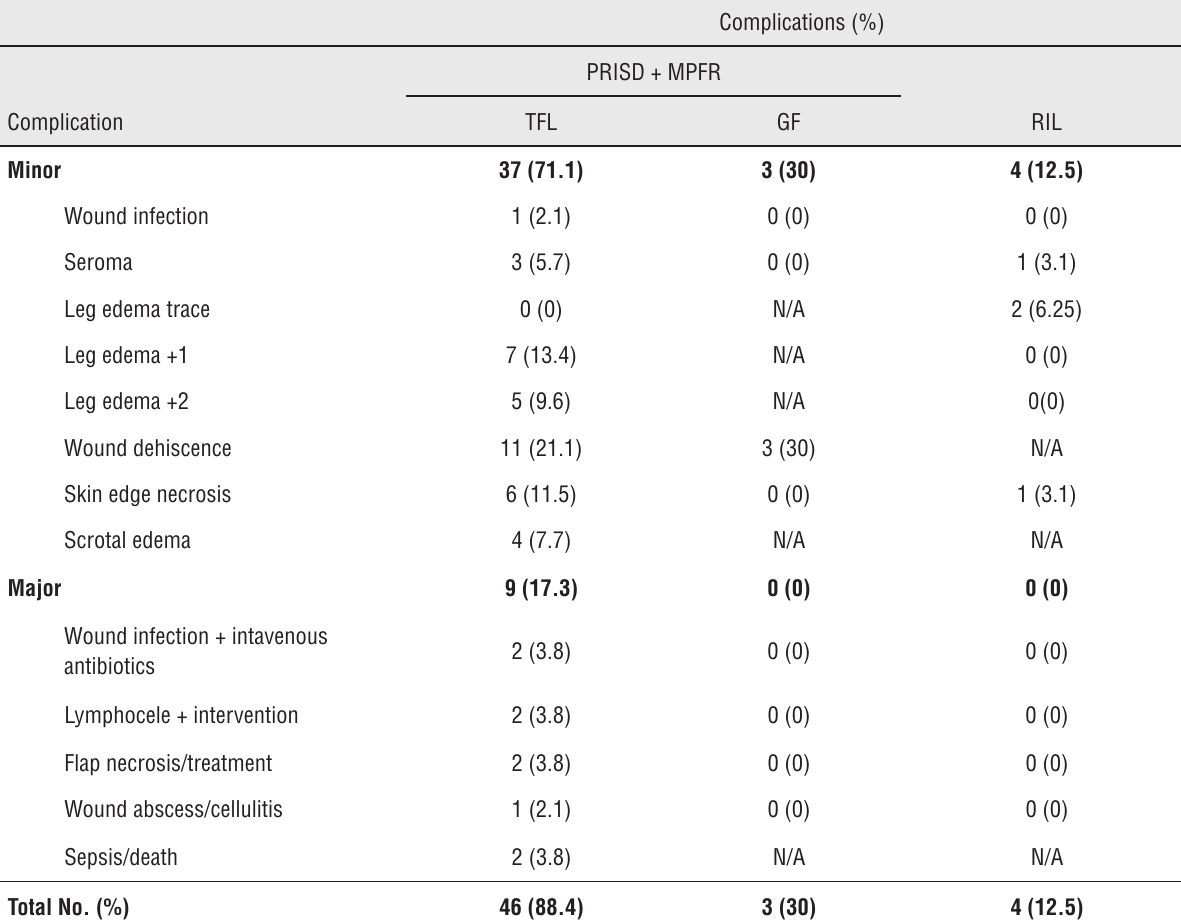
Table 2 - Complications related to 52 PRISD with 62 MPFR (52 TFL and 10 GF) and 32